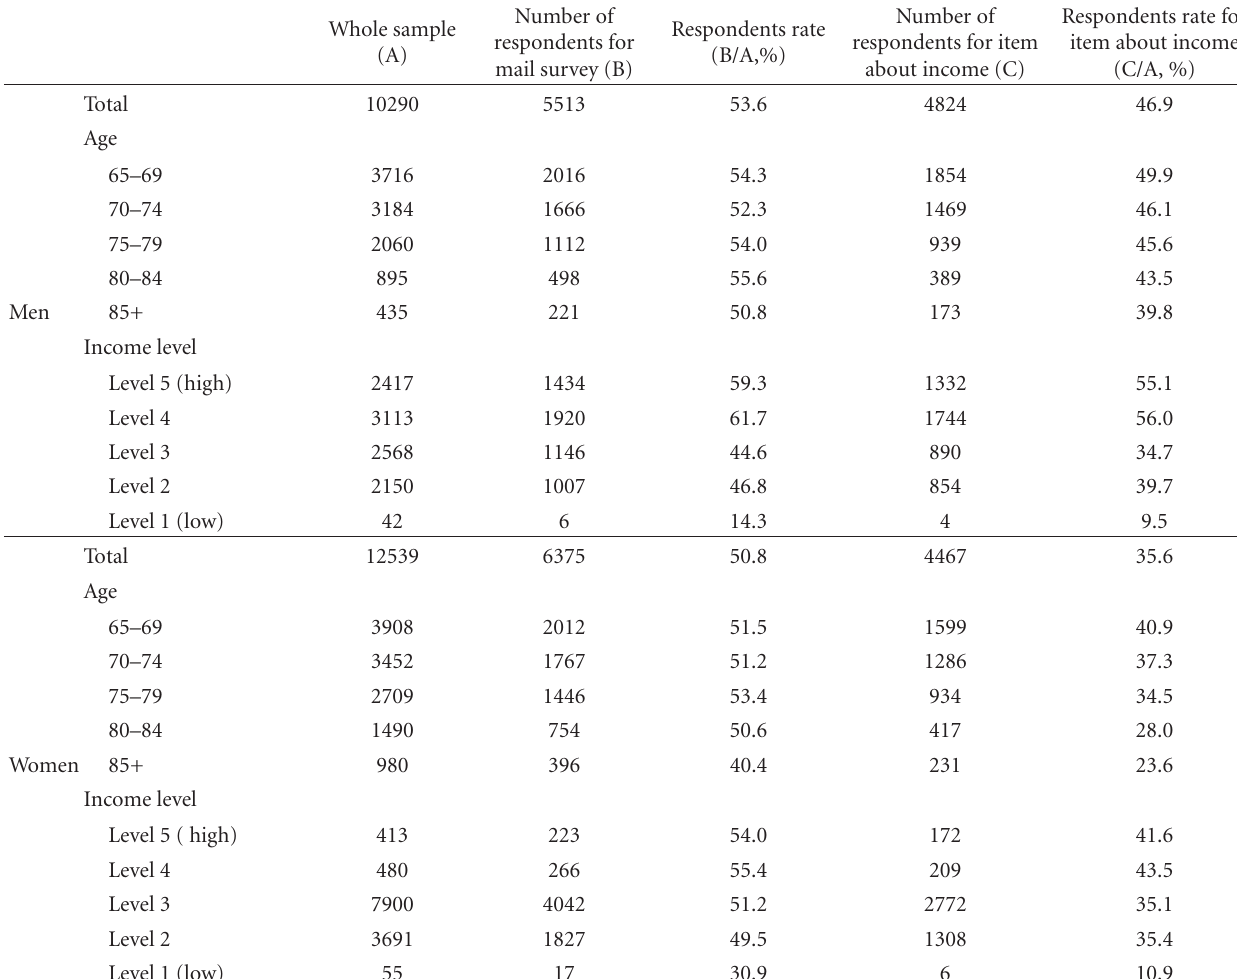
Table 3: Respondents rate for mail survey and item about